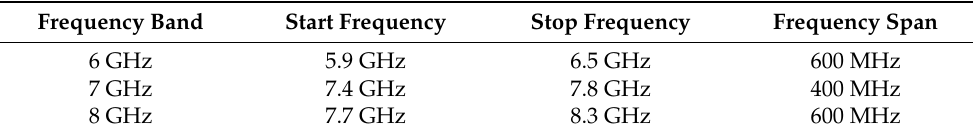
Figure 3. Experimental setup for the frequency scan measurements. Table 3. Frequency usage plan for the three different frequency bands